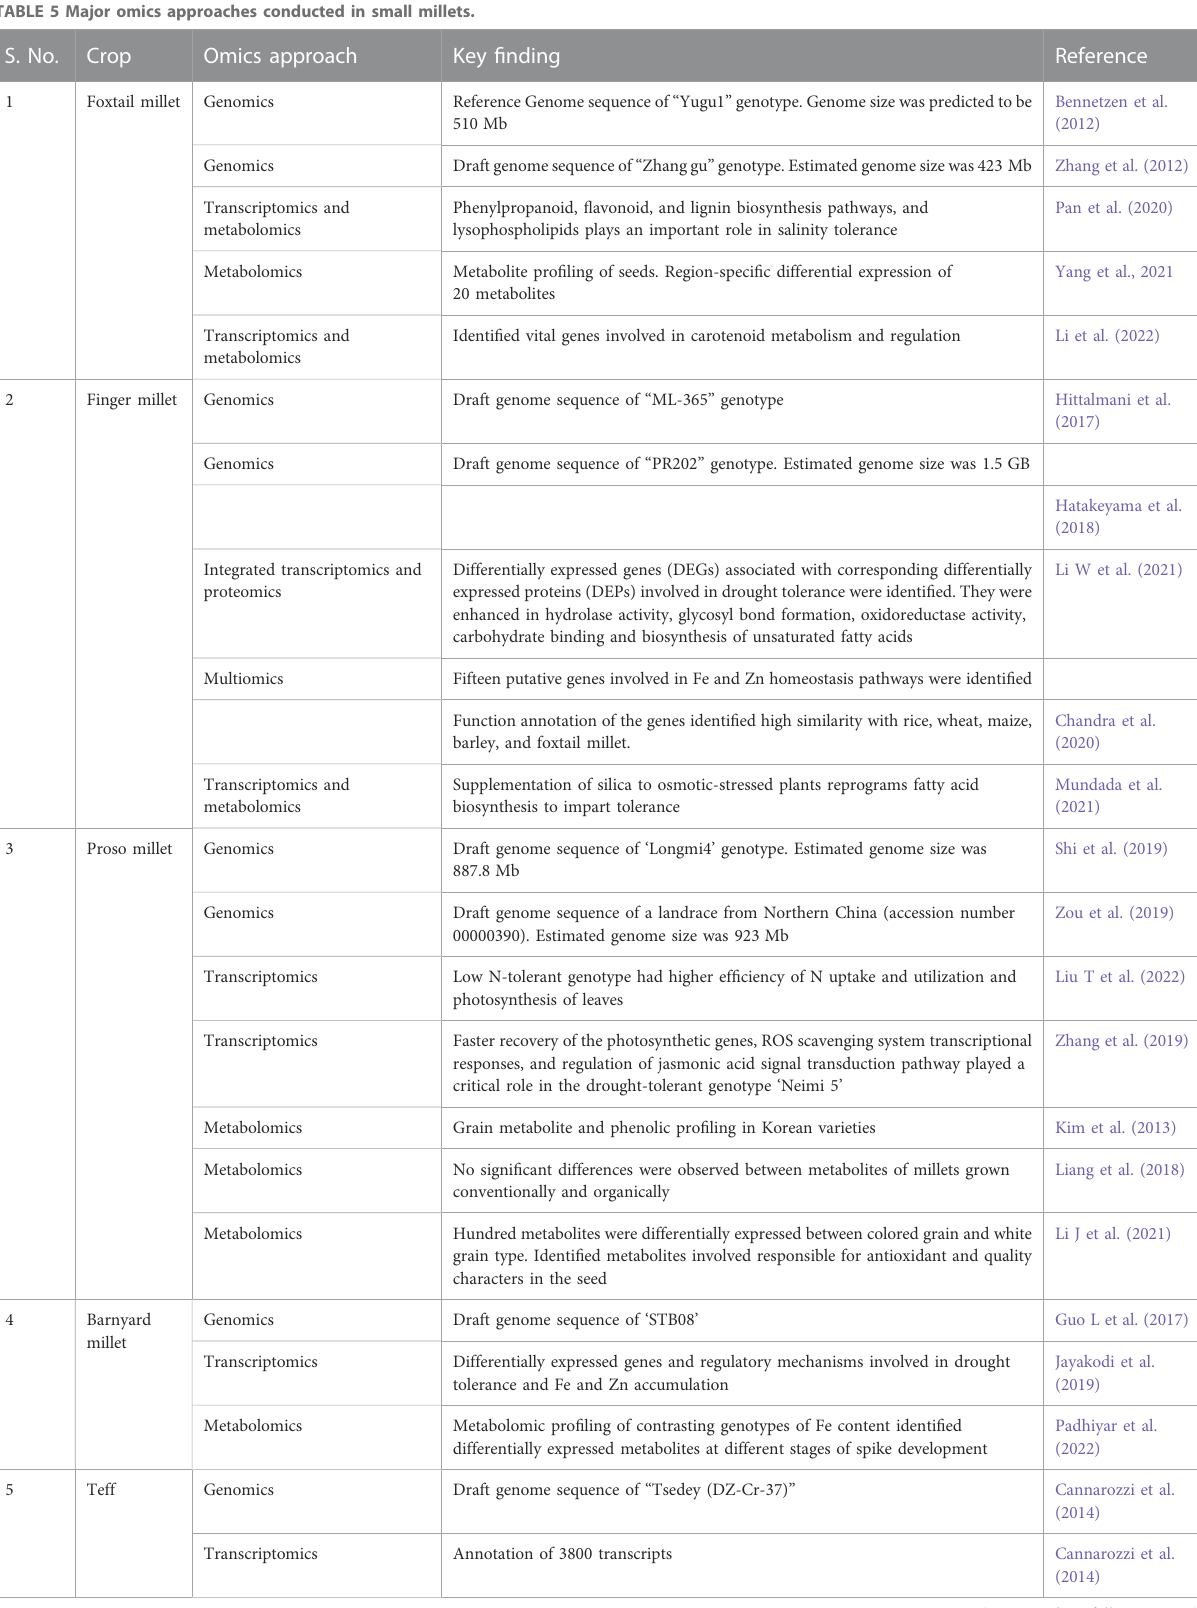
TABLE 5 Major omics approaches conducted in small